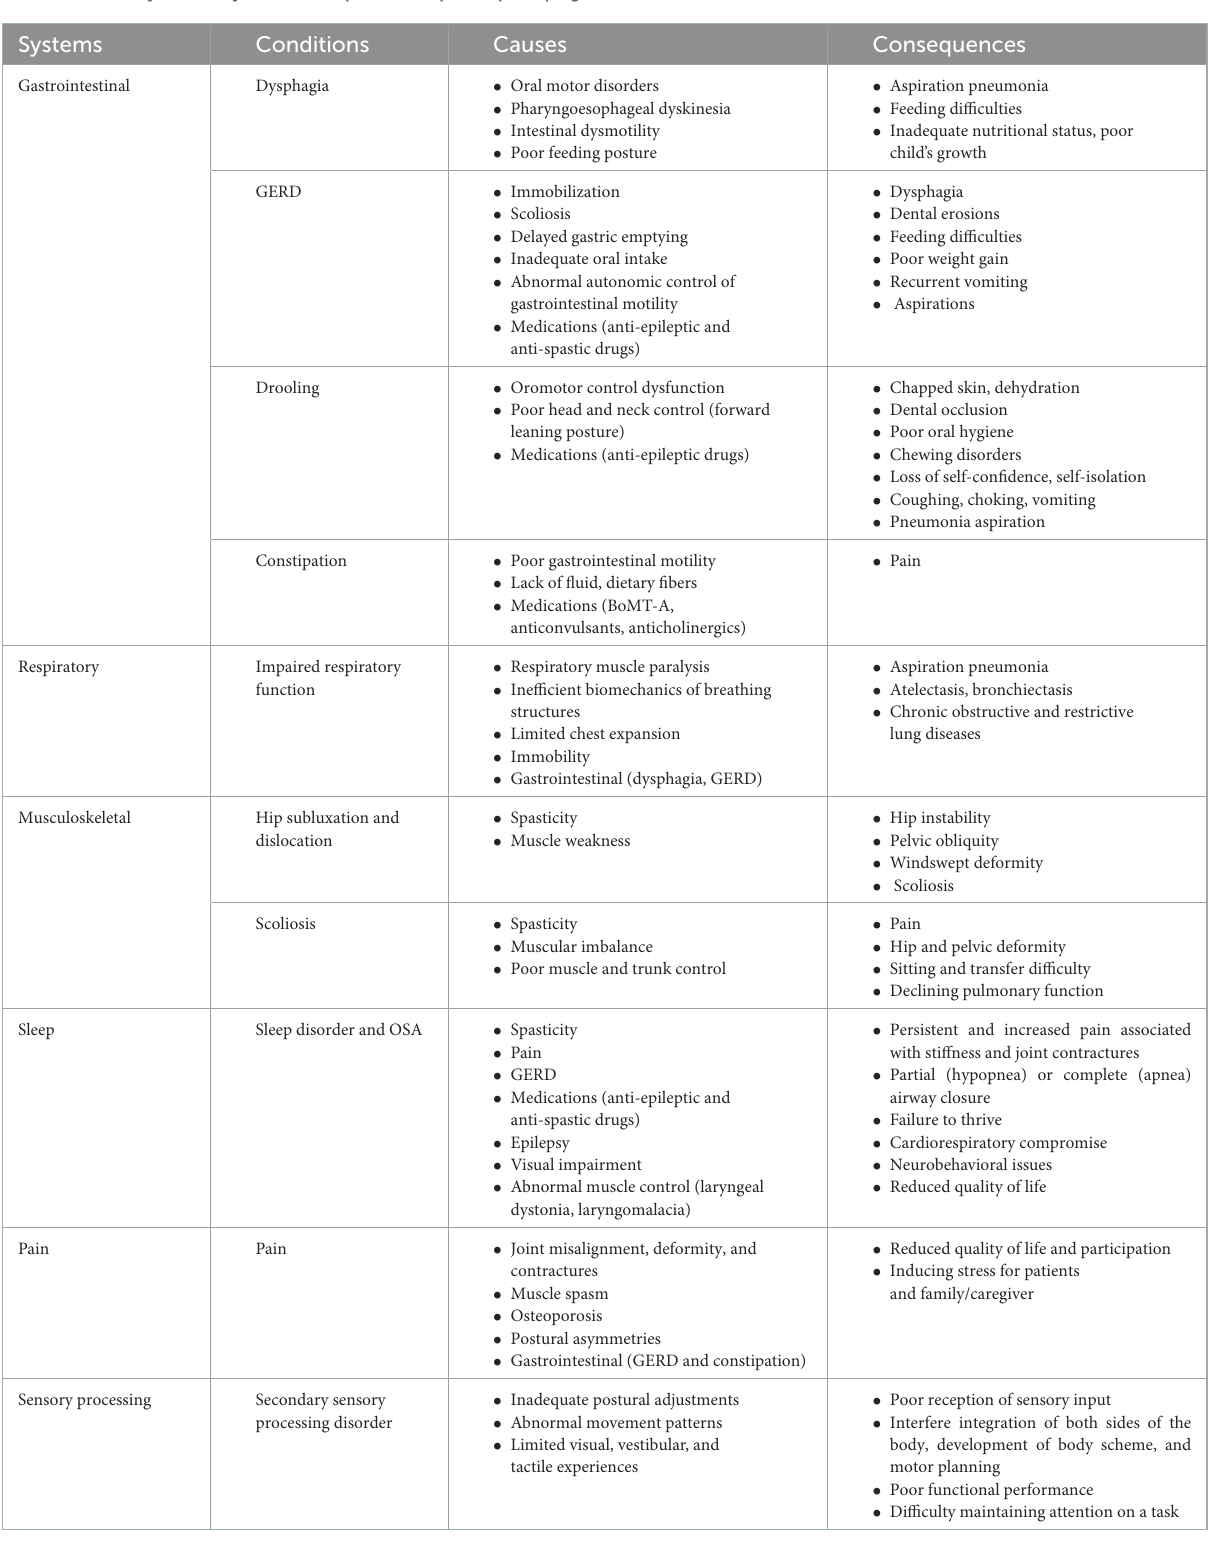
TABLE 1 Summary of multisystem consequences in spastic quadriplegic CP